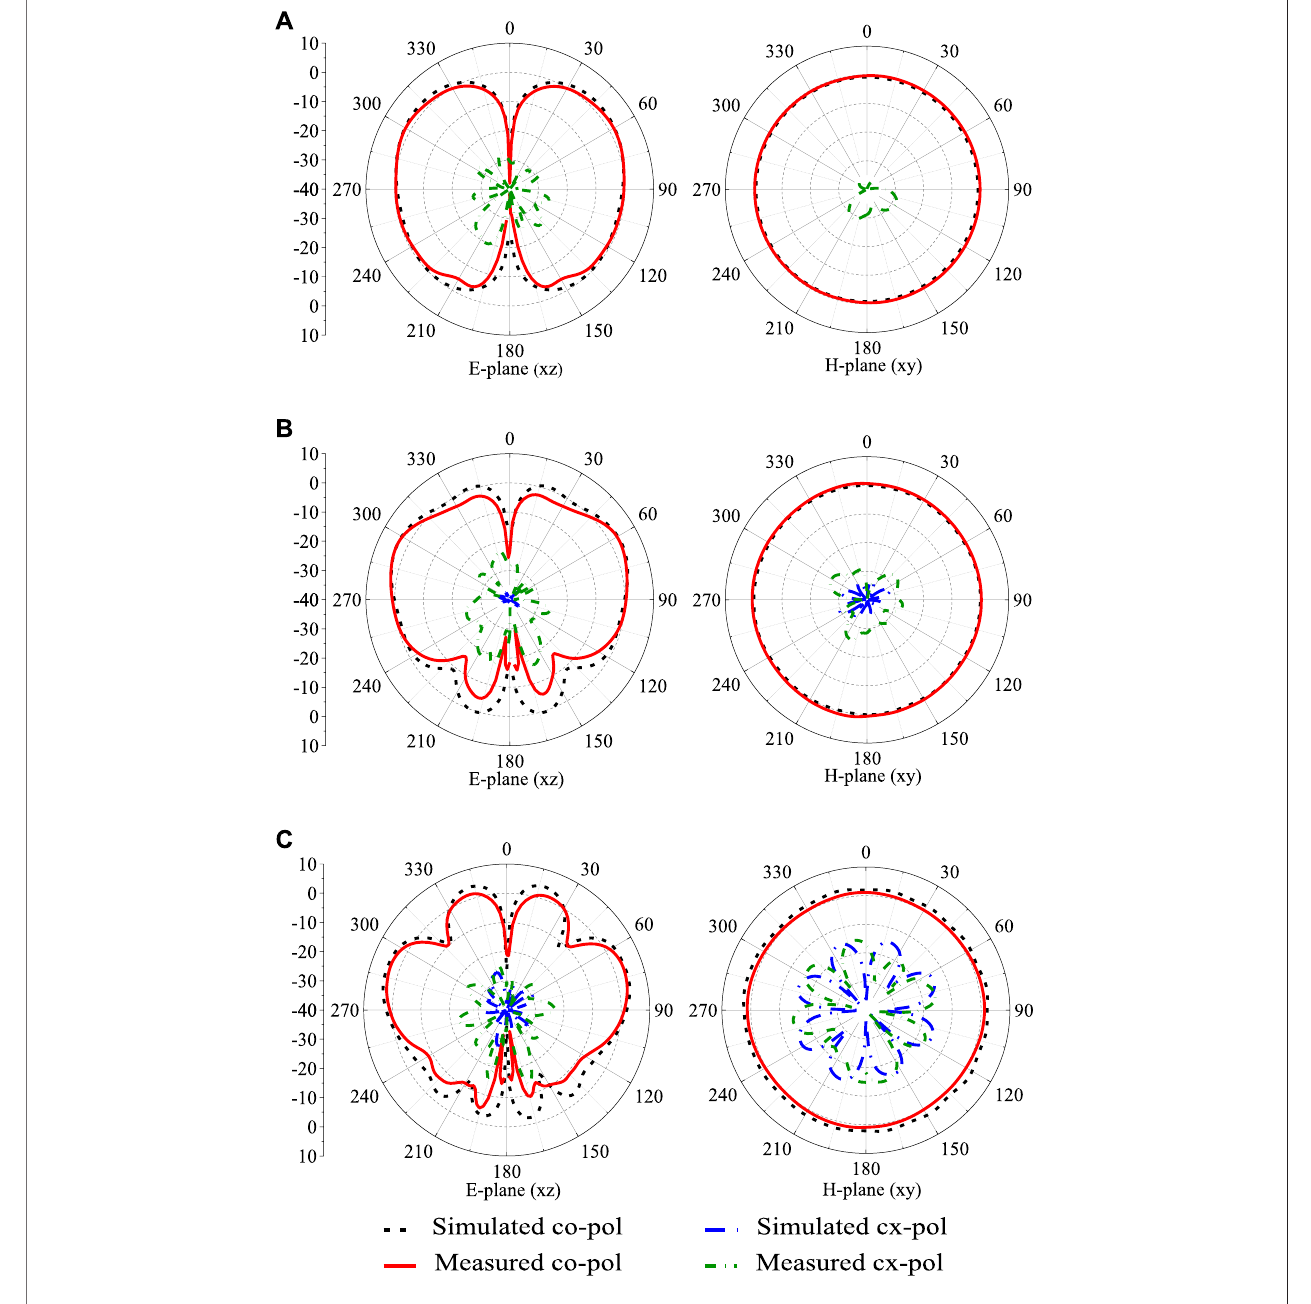
FIGURE 9 | Measured radiation patterns of the proposed antenna for E-plane (x-z plane) and H-plane (x-y plane) at (A) 1.7 GHz, (B) 3.5 GHz, and (C) 5 GHz.